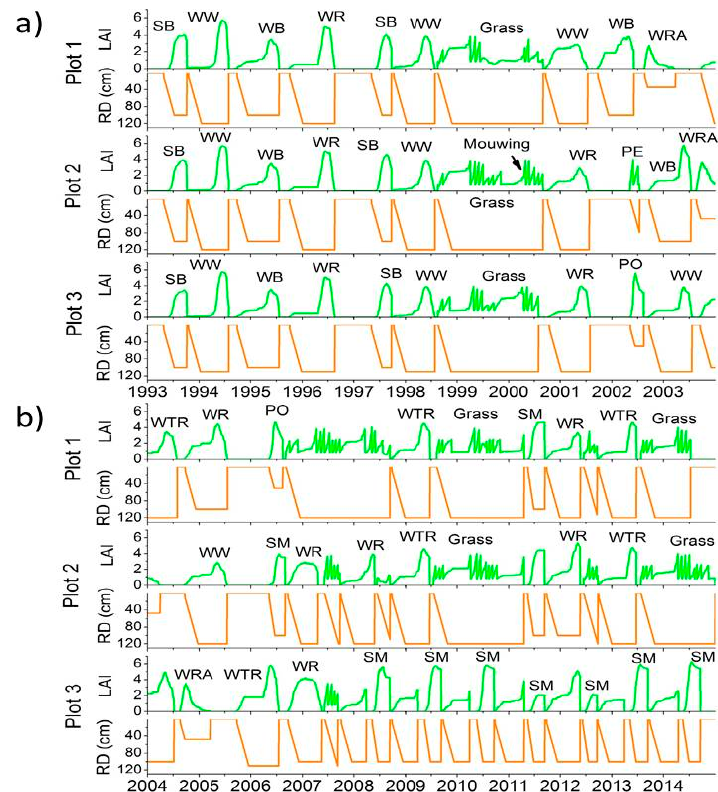
Figure 3. Simulated daily leaf area index (LAI) and rooting depth (RD), Plot 1–3 (SB = Sugar beet, WW = Winter wheat, WR = Winter rye, WB = Winter barley, Grass = Lucerne-clover-grass-mixture, WRA = Winter oil seed rape, PE = Peas, PO = Potatoes, WTR = Winter triticale, SM = Silage maize): ( a ) 1993–2003; ( b ) 2004–2014.